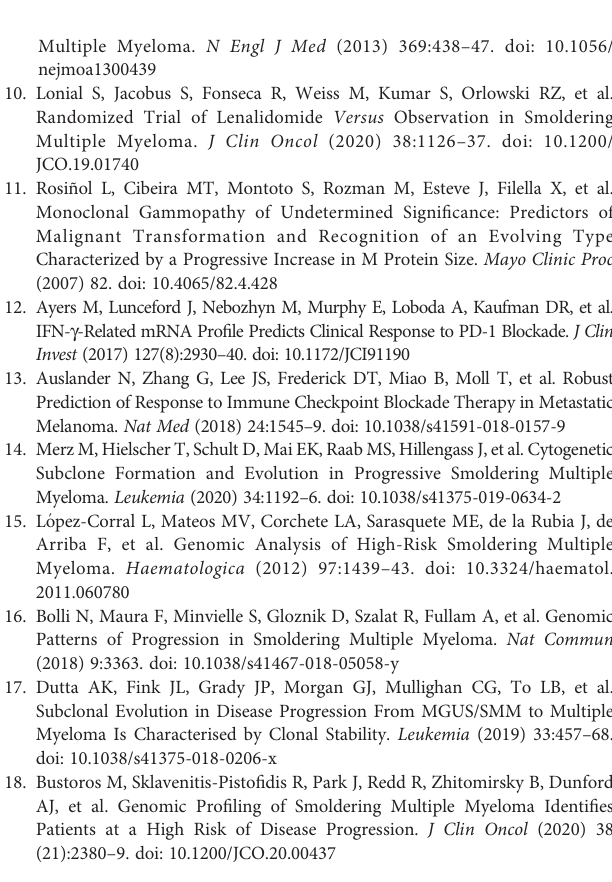
Supplementary Figure 1 | Genes upregulated in 5 patients with SMM compared totheirgenepro fi leafterprogression tosymptomatic MM (A) Heatmapshowingthe unsupervised hierarchical clustering of 5 patients before and after progression. (B) Expression of ITIM-bearing receptors, poliovirus receptor (PVR) and leukocyte immunoglobulin like receptor B3 (LILRB3) before and after progression. Supplementary Figure 2 | Analysis of progression free survival versus genes differentially expressed in patients with SMM. (A) Kaplan-Maier plot showing progression free survival (PFS) of patients (n=28) versus indicated genes. Upregulation of TNF superfamily members were associated to shorter PFS. Long- rank test p values are indicated. (B) High expression of genes such as MAPK14, Thrombospondin 1 ( THBS1 ), transcription factor FOS and SMAD3 were associated to longer PFS. Long-rank test p values are